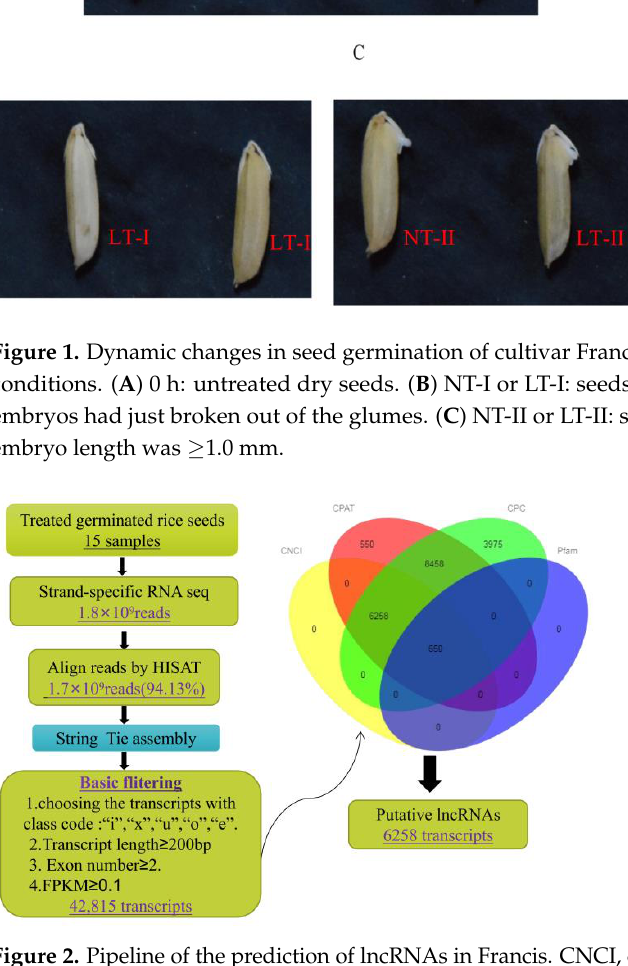
Figure 2. Pipeline of the prediction of lncRNAs in Francis. CNCI, coding non-coding index; CPC, coding potential calculator; CPAT, Coding Potential Assessment Tool; Pfam, a database of protein families.